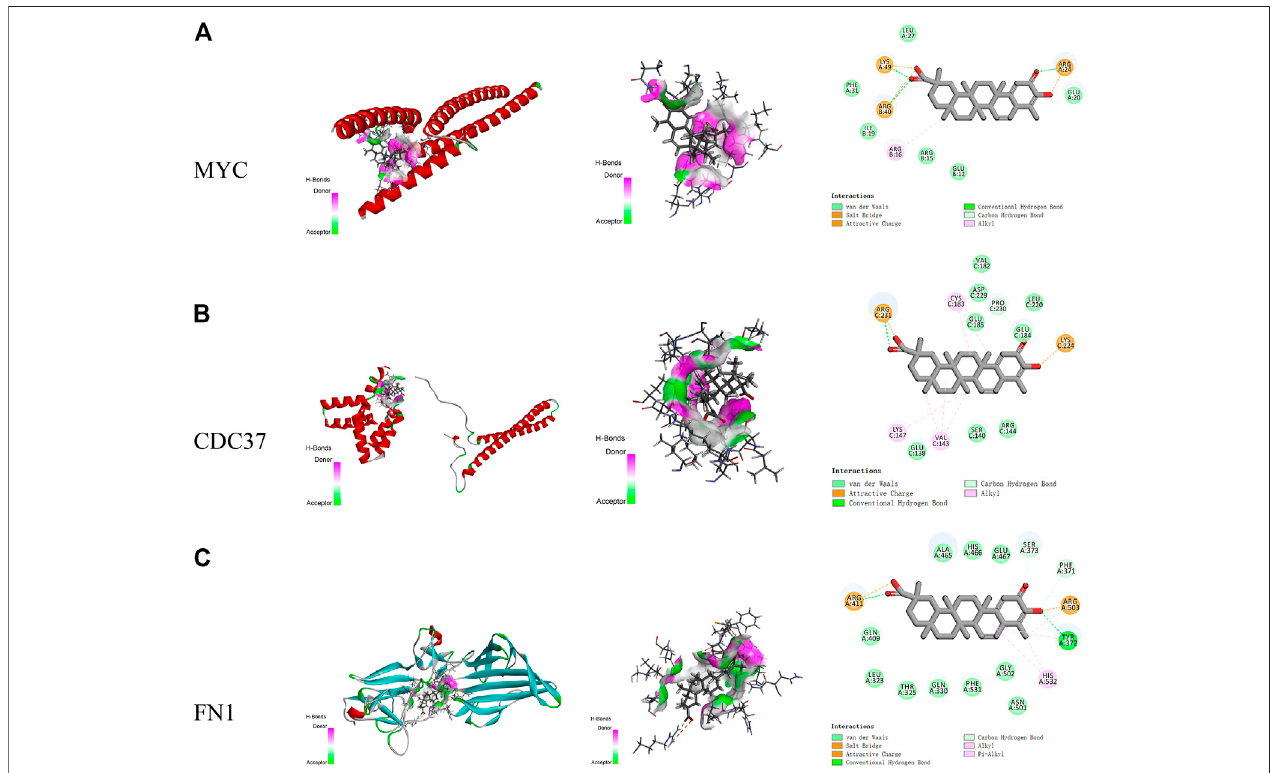
FIGURE 6 | The interactions between celastrol and its core targets. (A) The interaction between celastrol and MYC. (B) The interaction between celastrol and CDC37. (C) Theinteraction betweencelastrolandFN1. InH-bonds,pinkindicates thedonor,whilegreenindicates theacceptor.Intheinteractions,greenindicatesvan der Waals interactions, light green indicates carbon-hydrogen bonds, dark green indicates conventional hydrogen bonds, yellow indicates salt bridges and attractive charges, and pink indicates alkyl and pi-alkyl interactions.